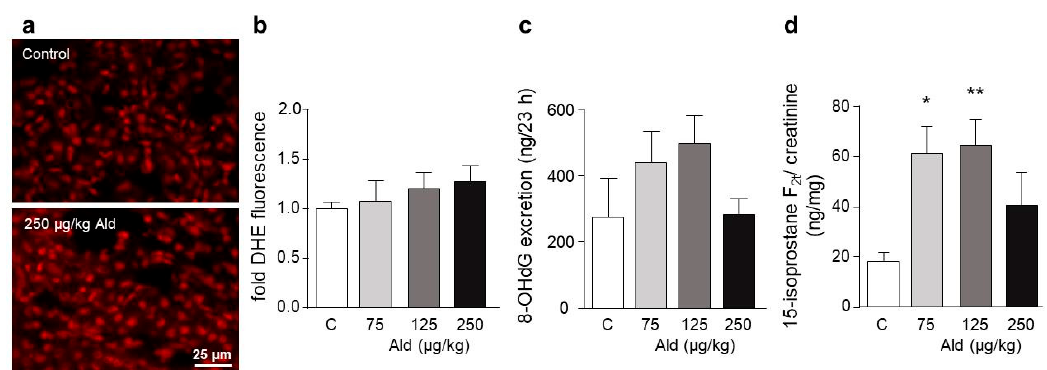
Figure 3. Reactive oxygen species (ROS) in kidneys of aldosterone-infused mice. For the visualization of ROS, cryosections of kidneys were incubated with the ROS-sensitive fluorescent dye dihydroethidium (DHE). ( a ) Representative pictures of DHE stained kidney sections. ( b ) Quantification of ROS production by measuring the mean grey value of nuclei within 10 visual fields with Image J. ( c ) Amount of the excised oxidized nucleobase 8-OHdG excreted in urine. ( d ) Amount of the lipid peroxidation product 15-isoprostane F 2t related to urinary creatinine. 8-OHdG: 8-hydroxy- 2'-deoxyguanosine, Ald: aldosterone. Data are shown as mean + SEM, n = 4–5. * p ≤ 0.05, ** p < 0.01 vs. C: control group.